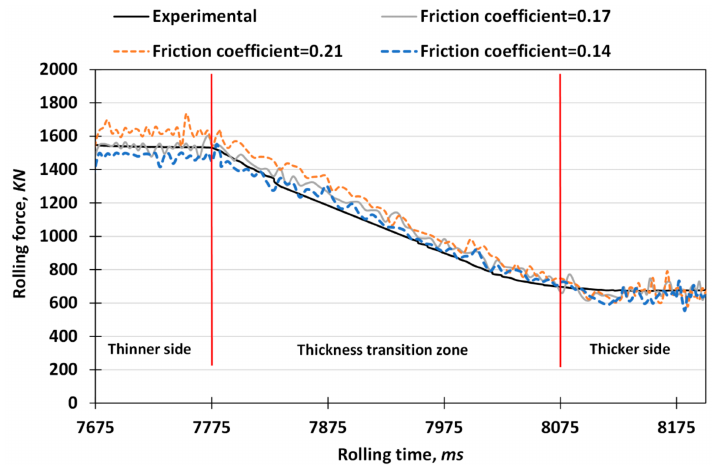
Figure 4. Estimation of friction coefficient during